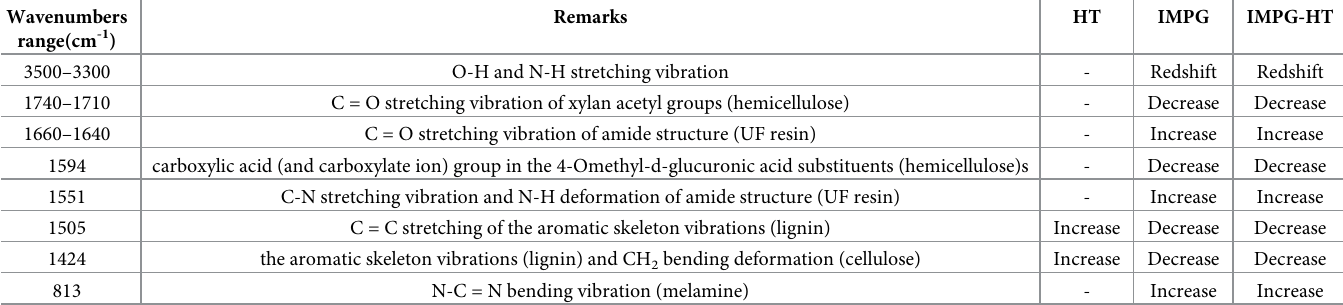
Table 2. Assignments of characteristic band on the infrared spectrum of the modified wood and their differences with untreated wood. Wavenumbers range(cm -1